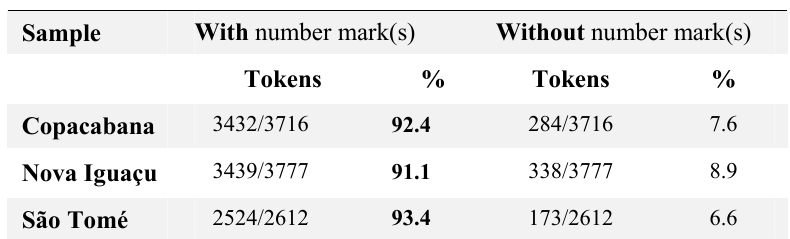
Table IV. Distribution of NP constituents with and without number mark(s) within urban varieties of BP and STP